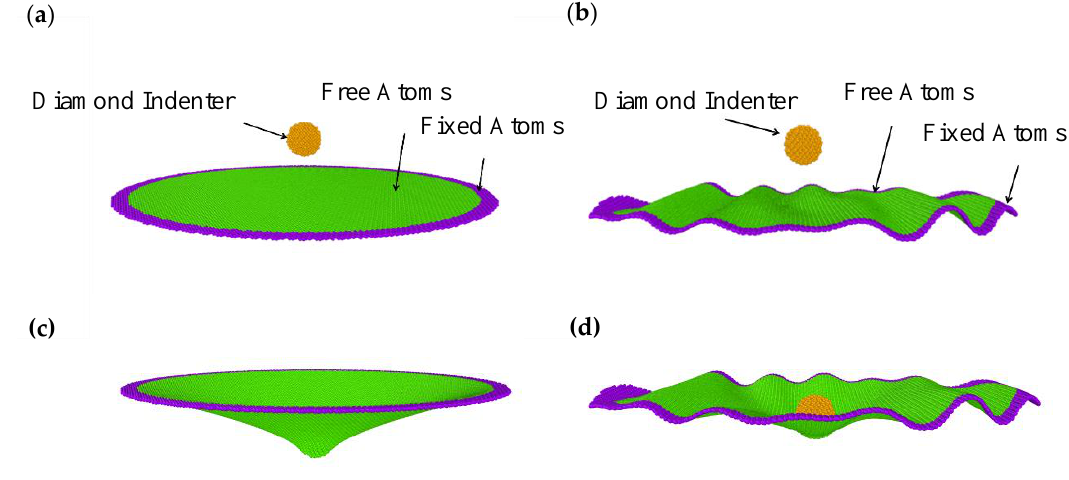
Figure 2. The molecular dynamics (MD) models of the ( a ) perfect and ( b ) wrinkled circular graphene sheets for nanoindentation simulations, and the arbitrary states of indentation on the ( c ) perfect and ( d ) wrinkled graphenes.